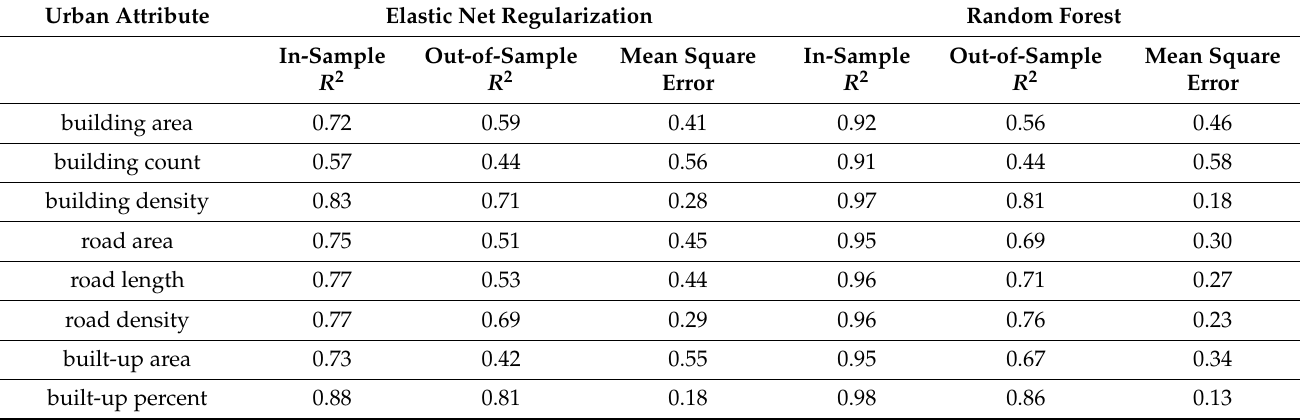
Table 10. R 2 and mean square error values for urban attributes using elastic net regularization and random forest models with Sentinel-2 imagery for Sri Lanka (333 Grama Niladhari